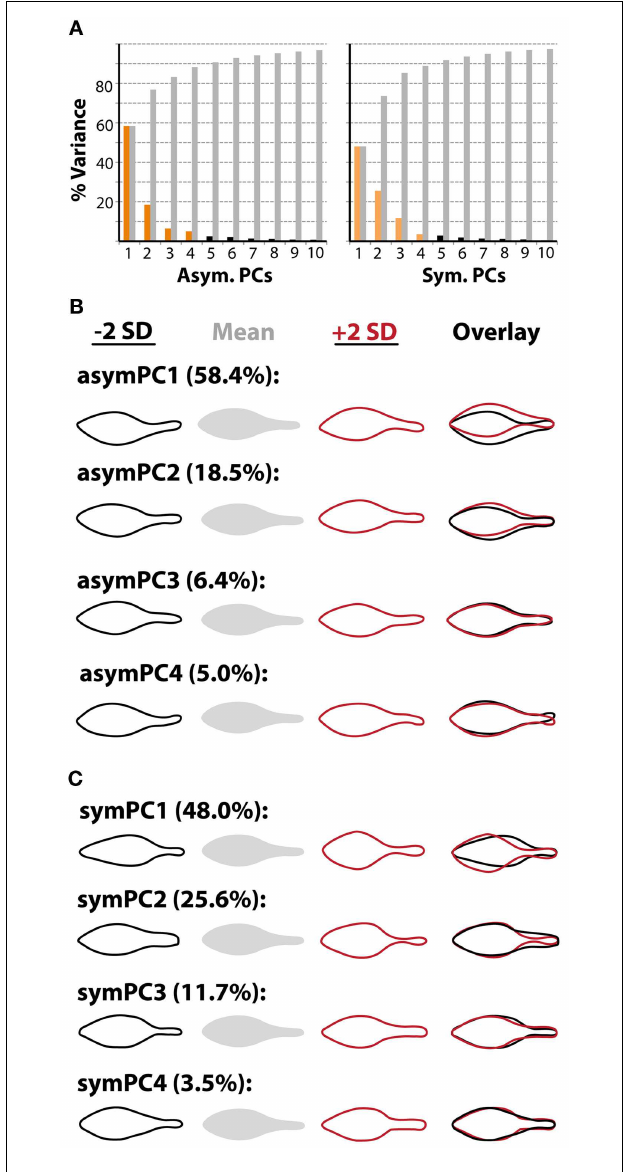
FIGURE 3 | Principal components describing symmetrical and asymmetrical shape variance. (A) Both abaxial-top and adaxial-bottom images were used in an Elliptical Fourier Descriptor (EFD) analysis to examine asymmetric shape variance. Abaxial-top images only were used in an analysis of symmetric shape variance, as mirror images were not needed to analyze asymmetry. Shown is the percent variance in asymmetric (left) and symmetric (right) analyses explained by each PC. Note that the amount of variance described by the first PCs (asymPC1: 58.4%, symPC1: 48.0%) is relatively high, and that collectively the first four PCs describe a large amount of the overall variance (asymPCs1–4: 88.3%, symPCs1–4: 88.8%). (B) Leaflet outlines representing ± 2 standard deviations along asymmetric principal component axes. Particular attention